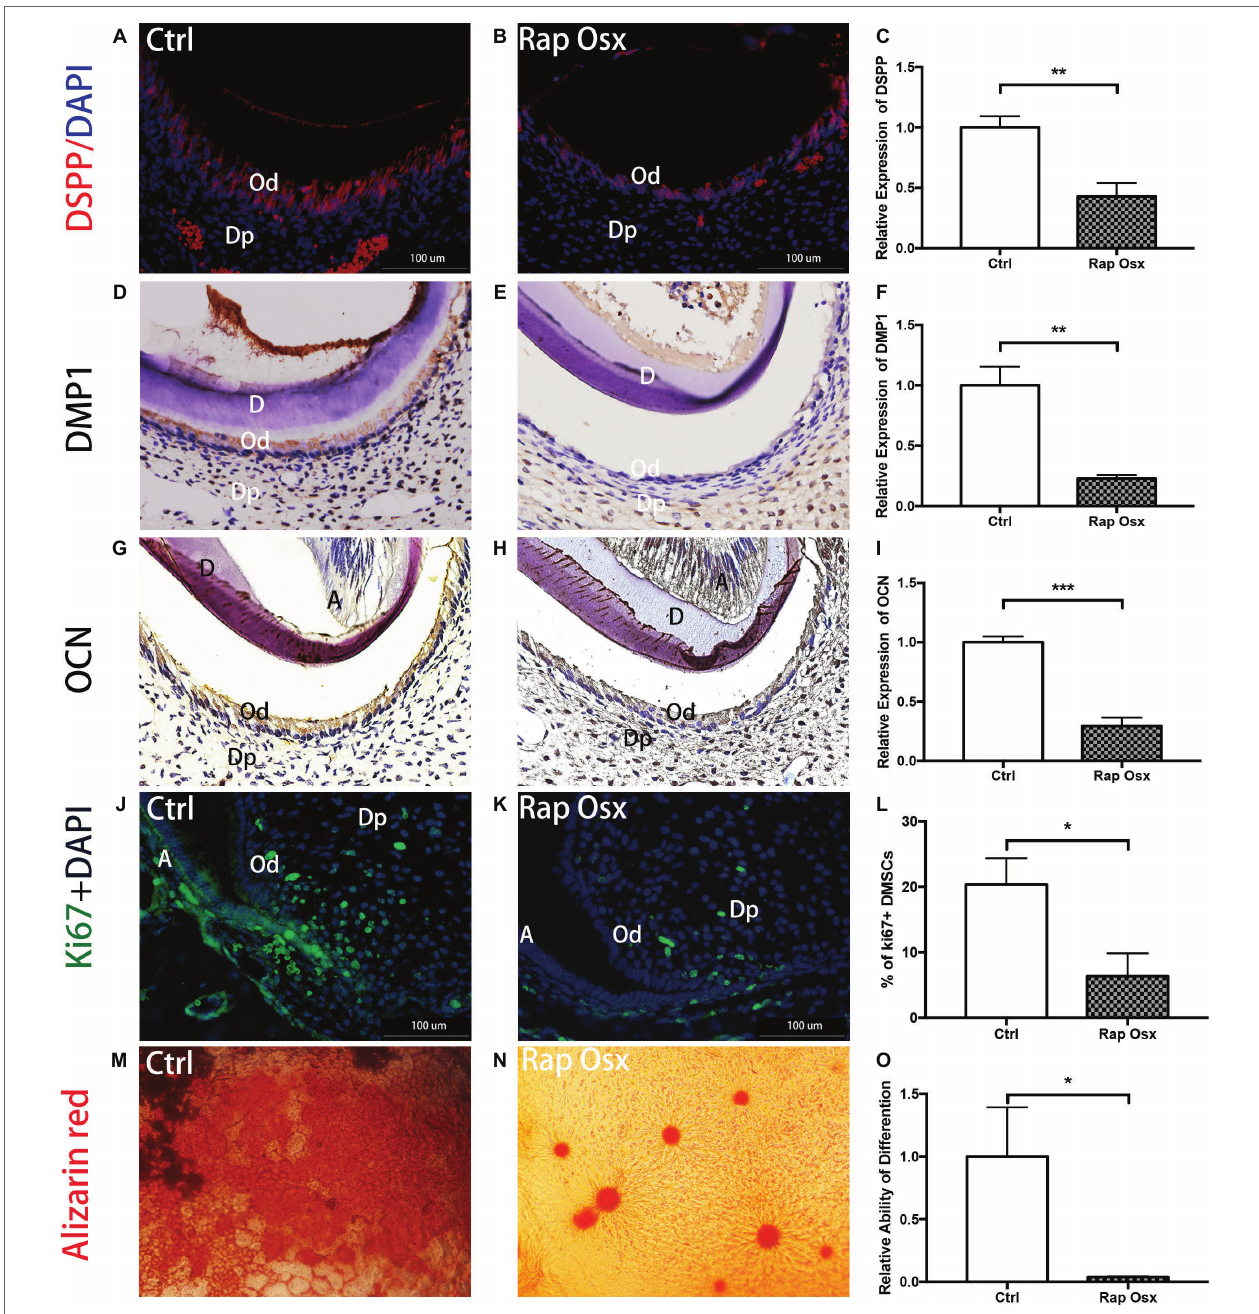
FIGURE 3 | Rap-Osx mice showed repressed odontoblast proliferation, differentiation and DSPP secretion. (A,B) The protein expression of DSPP in developmental teeth of Rap-Osx mice and Ctrl mice. (D,E) The protein expression of DMP1 in developmental teeth of Rap-Osx mice and Ctrl mice. (G,H) The protein expression of OCN in developmental teeth of Rap-Osx mice and Ctrl mice. (J,K) The protein expression of Ki67 in developmental teeth of Rap-Osx mice and Ctrl mice. (C,F,I) The protein expression levels of DSPP, DMP1 and OCN in developmental teeth of Rap-Osx mice and Ctrl mice. (L) Quantitative analysis of the Ki67 positive dental mesenchymal cells in developmental teeth of Rap-Osx mice and Ctrl mice. (M,N) Alizarin red staining was performed on primary cultured dental mesenchymal cells from Ctrl and Rap-Osx mice after osteogenesis induction for 21 days. (O) Quantitative analysis of the relative differentiation ability, i.e., calcium knot formation ability. Data represent the mean ± SD (* p < 0.05, ** p < 0.001, *** p <